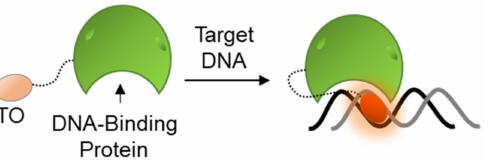
Figure 8. Sensing of DNA–protein interactions by TO-labeled DBPs. A chosen DBP is first covalently labeled with TO and then introduced to its target DNA. The proximity between the DNA and TO induces intercalation and a consequent increase in